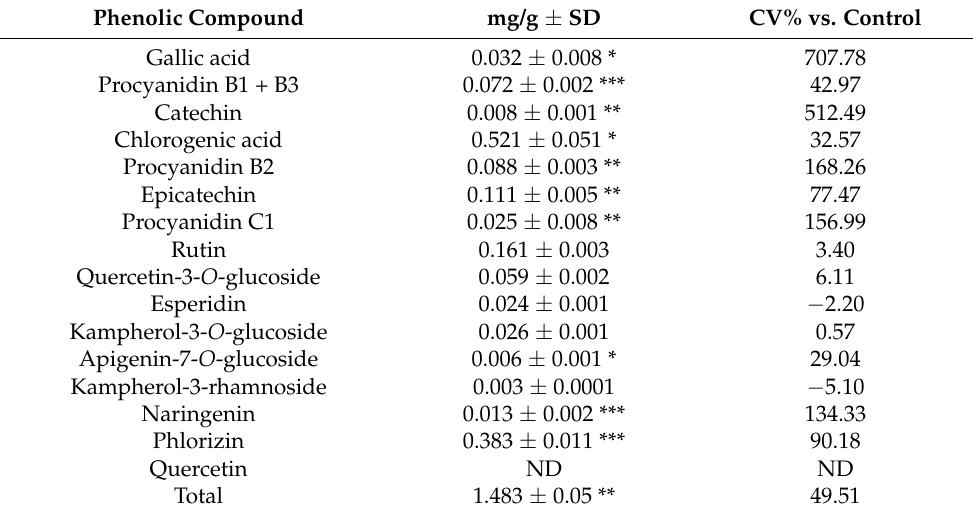
Table 1. Polyphenolic composition of ATLAA compared to the CTR.